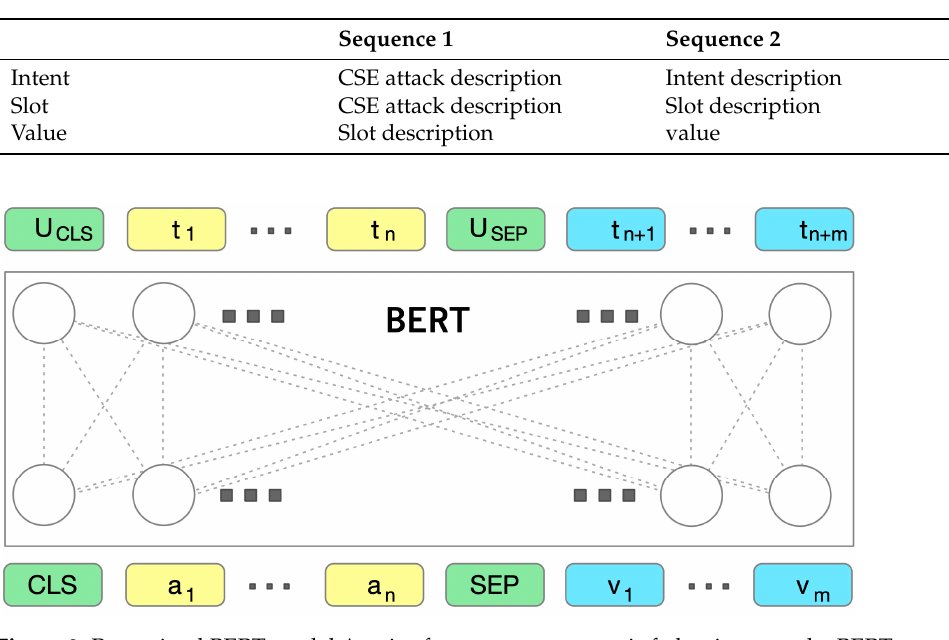
Figure 9. Pre-trained BERT model A pair of two sequences a, v is fed as input to the BERT encoder which outputs the pair’s embedding U CLS and the token representations {t 1 , …, t n+m }.